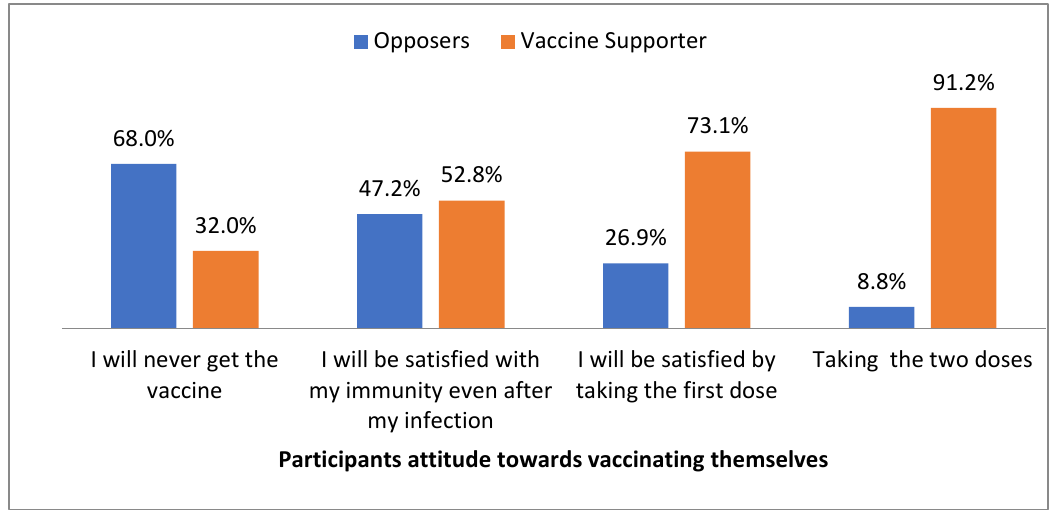
Figure 1. Participants ’ attitudes towards vaccinating themselves.